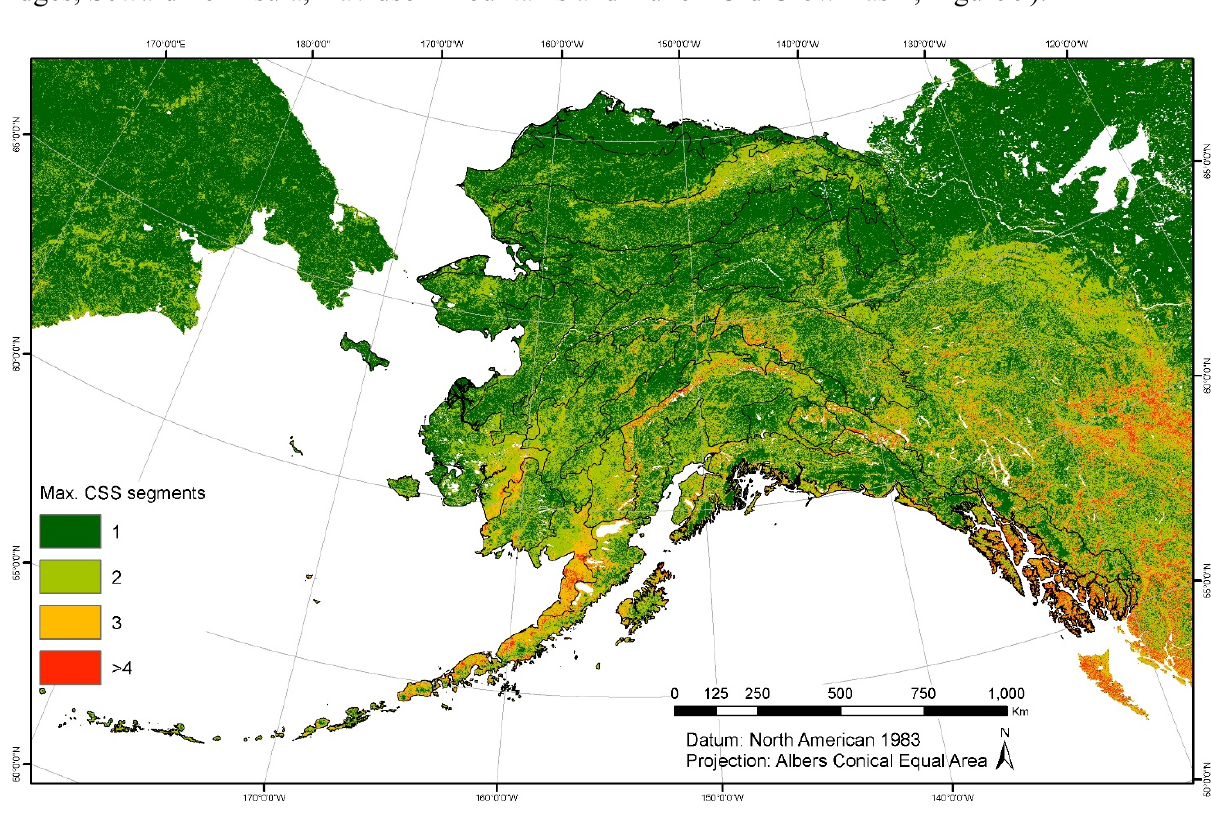
Figure 9. Maximum number of continuous snow season segments (CSN) in any winter during 2001–2013 snow years with respect to ecoregion [33]. Ecoregion data courtesy of U.S. Geological